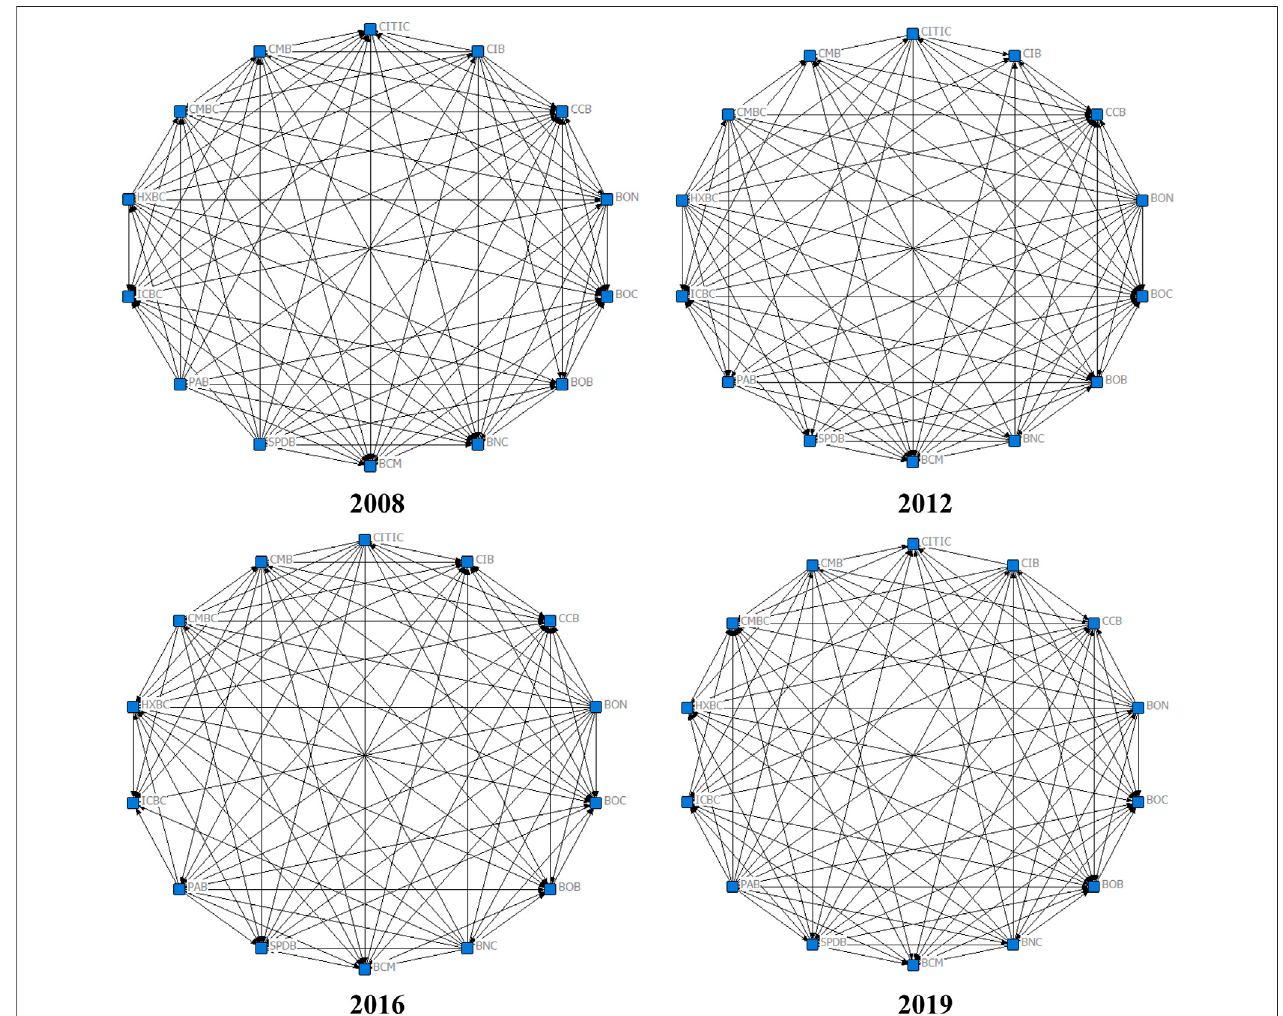
FIGURE 3 | Jump risk network of commercial